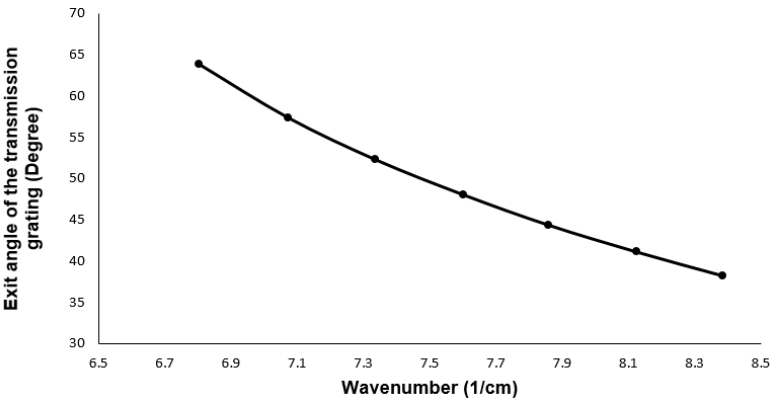
Figure 1. Exit angle of the light from the grating vs.